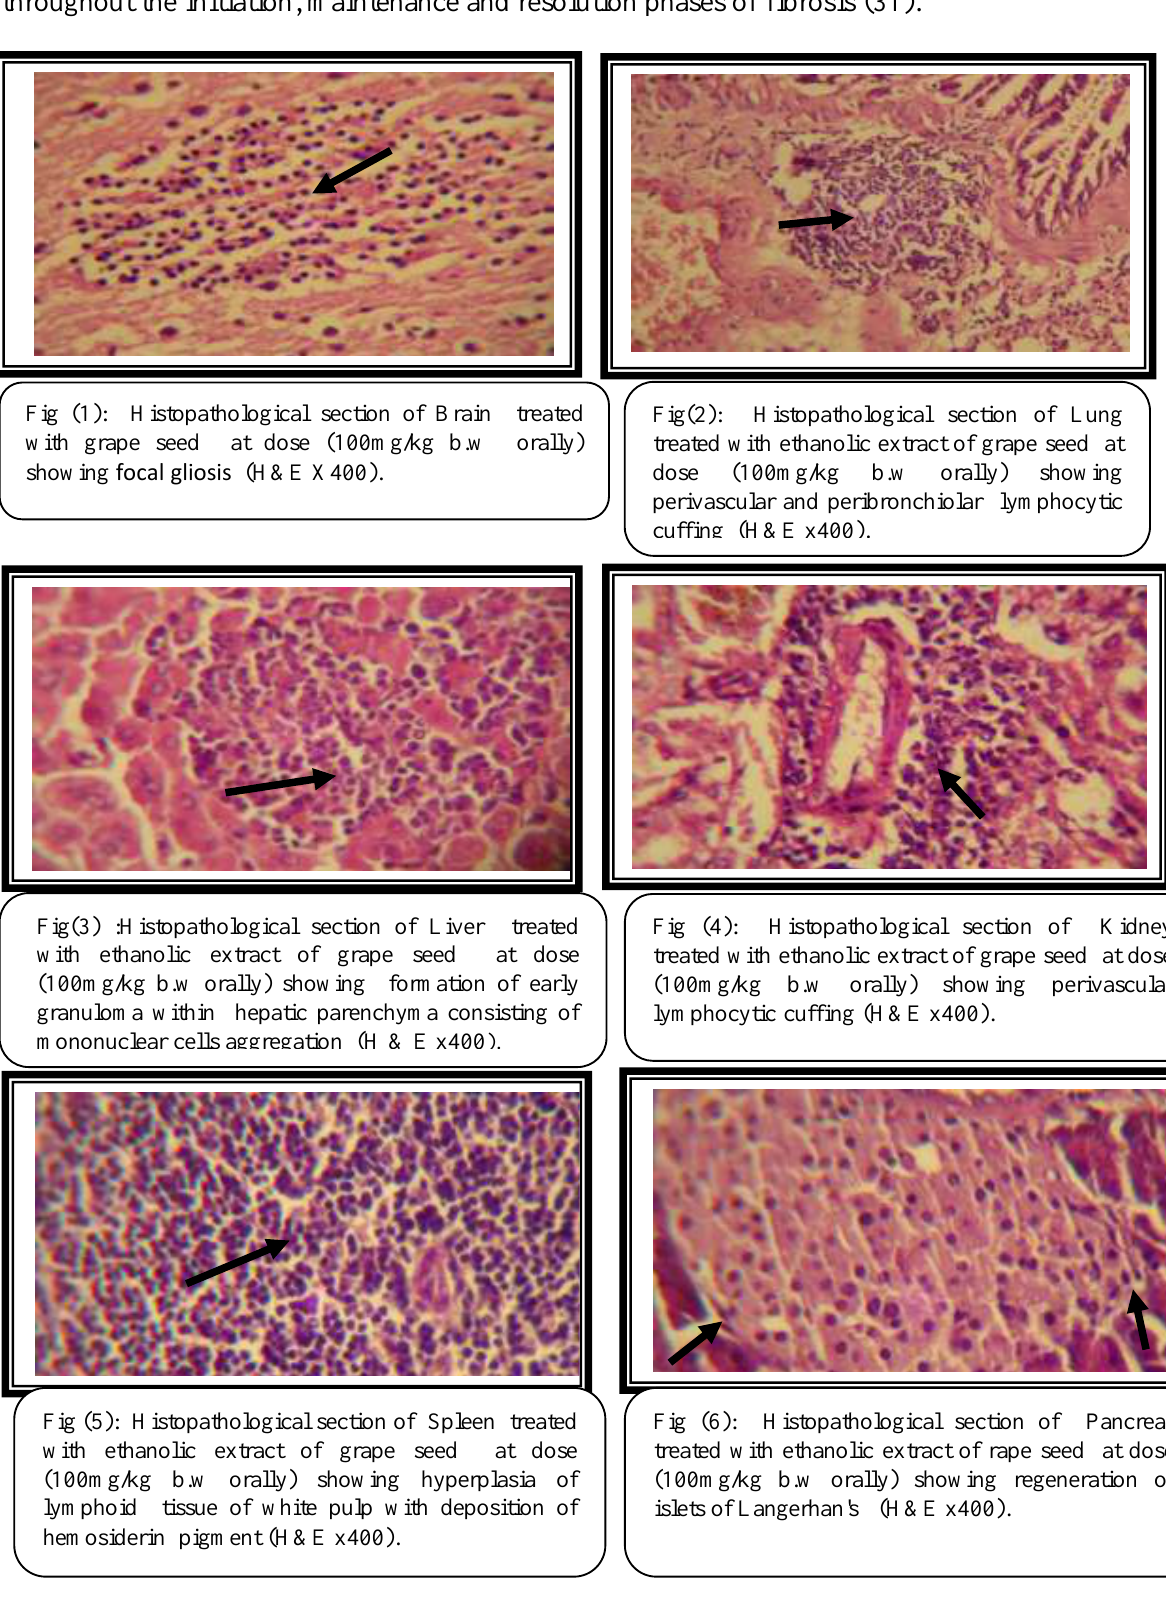
Fig (6): Histopathological section of Pancreas treated with ethanolic extract of rape seed at dose (100mg/kg b.w orally) showing regeneration of islets of Langerhan's (H&E